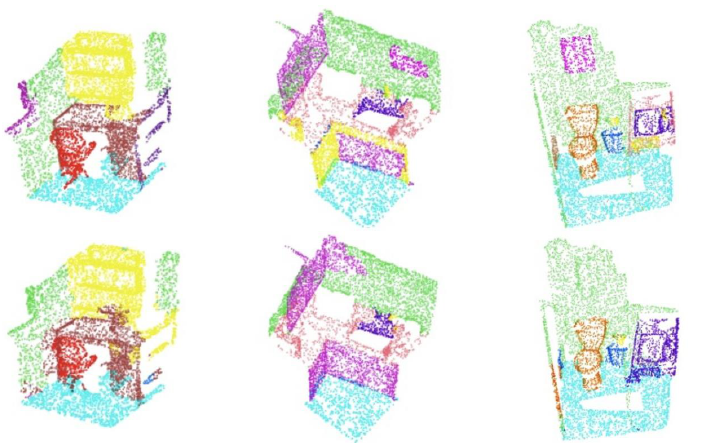
Figure 4. Randomly sampled point cloud from the ModelNet40 dataset. The pictures in the top row are the ground truth, and the pictures in the bottom row are the prediction. Different colors represent different object